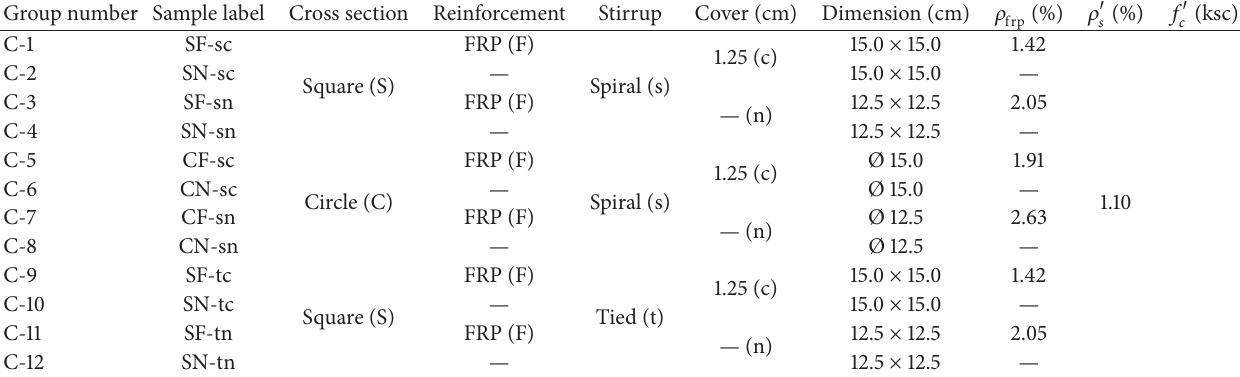
Table 1: Characteristics of the test specimens. Group number Sample label Cross section